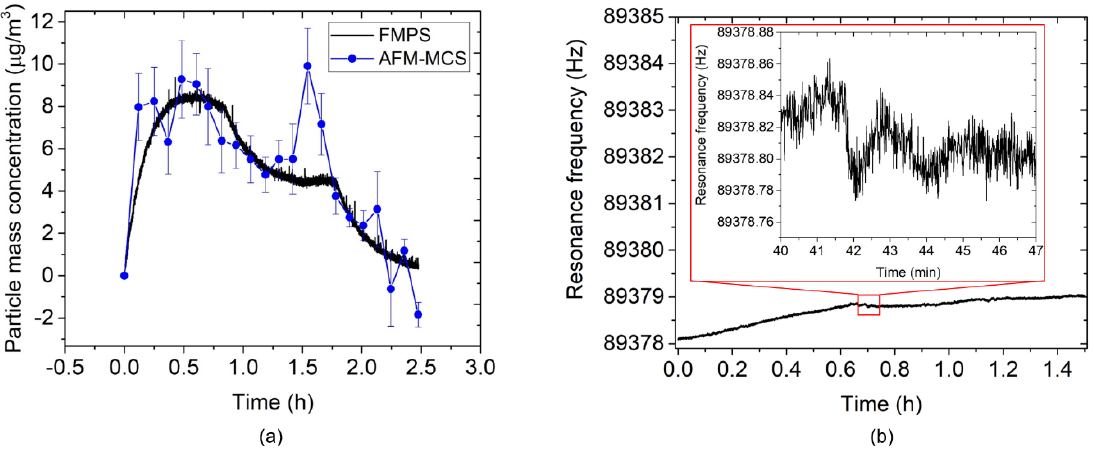
Figure 15. ( a ) Carbon-nanoparticle mass concentration measured by the AFM-MCS (full blue circle) in comparison with FMPS (full black line). ( b ) The frequency-stability measurement under a temperature of 23.01 ± 0.03 °C and relative humidity of 21.8 ± 0.4%. The inset shows an exemplary detailed enlargement of the frequency tracking within 7 min showing σ ≈ 17 mHz.